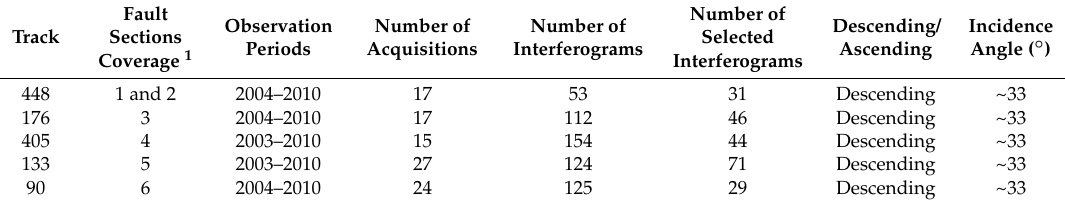
Table 1. Details of SAR data in our